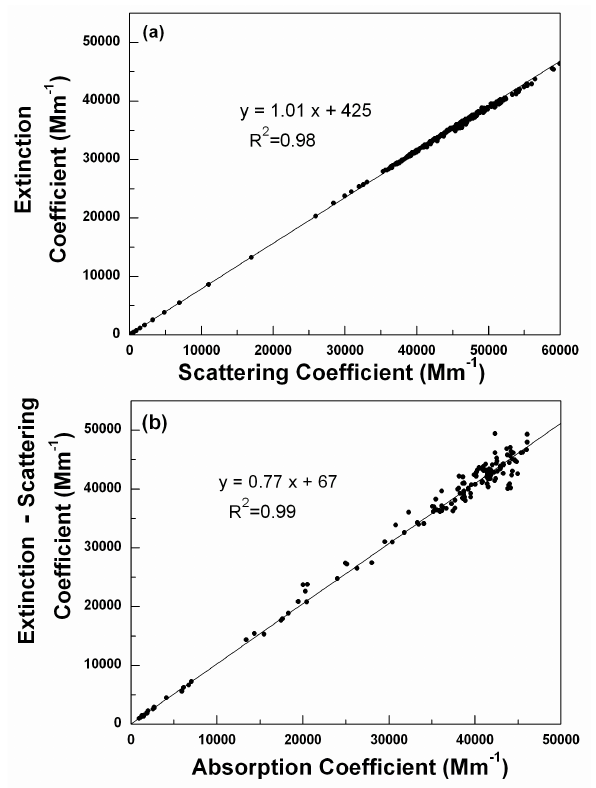
Fig. 1. Plots of 355nm calibration curves for (a) scattering mea- surements of negligibly absorbing salt aerosol, and (b) absorption measurements of kerosene